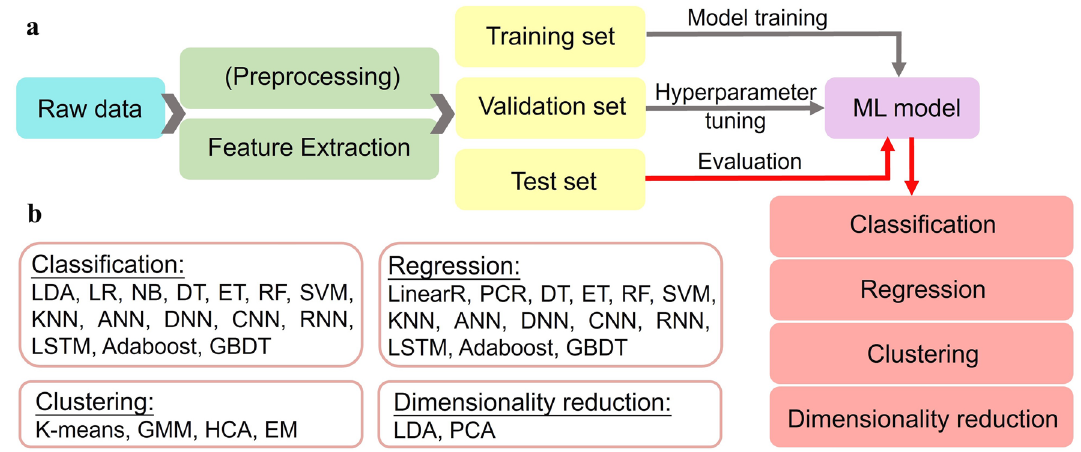
Fig. 8 The general process of ML techniques for data interpretation. (b) Common ML algorithms for classification, regression, clustering, and dimensionality reduction. LDA: Linear Discriminant Analysis. LR: Logistic Regression. NB: Naive Bayes. DT: Decision Tree. ET: Extra Tree (Extremely Randomized Tree). RF: Random Forest. SVM: Support Vector Machine. kNN: k-Nearest Neighbor. ANN: Artificial Neural Network. DNN: Deep Neural Network. CNN: Convolutional Neural Network. RNN: Recurrent Neural Network. LSTM: Long Short-Term Memory. Ada- boost: Adaptive Boosting. GBDT: Gradient Boosting. LinearR: Linear Regression. PCR and PCA: Principal Component Regression/Analysis. GMM: Gaussian Mixture Model. HCA: Hierarchical Clustering Analysis. EM: Expectation